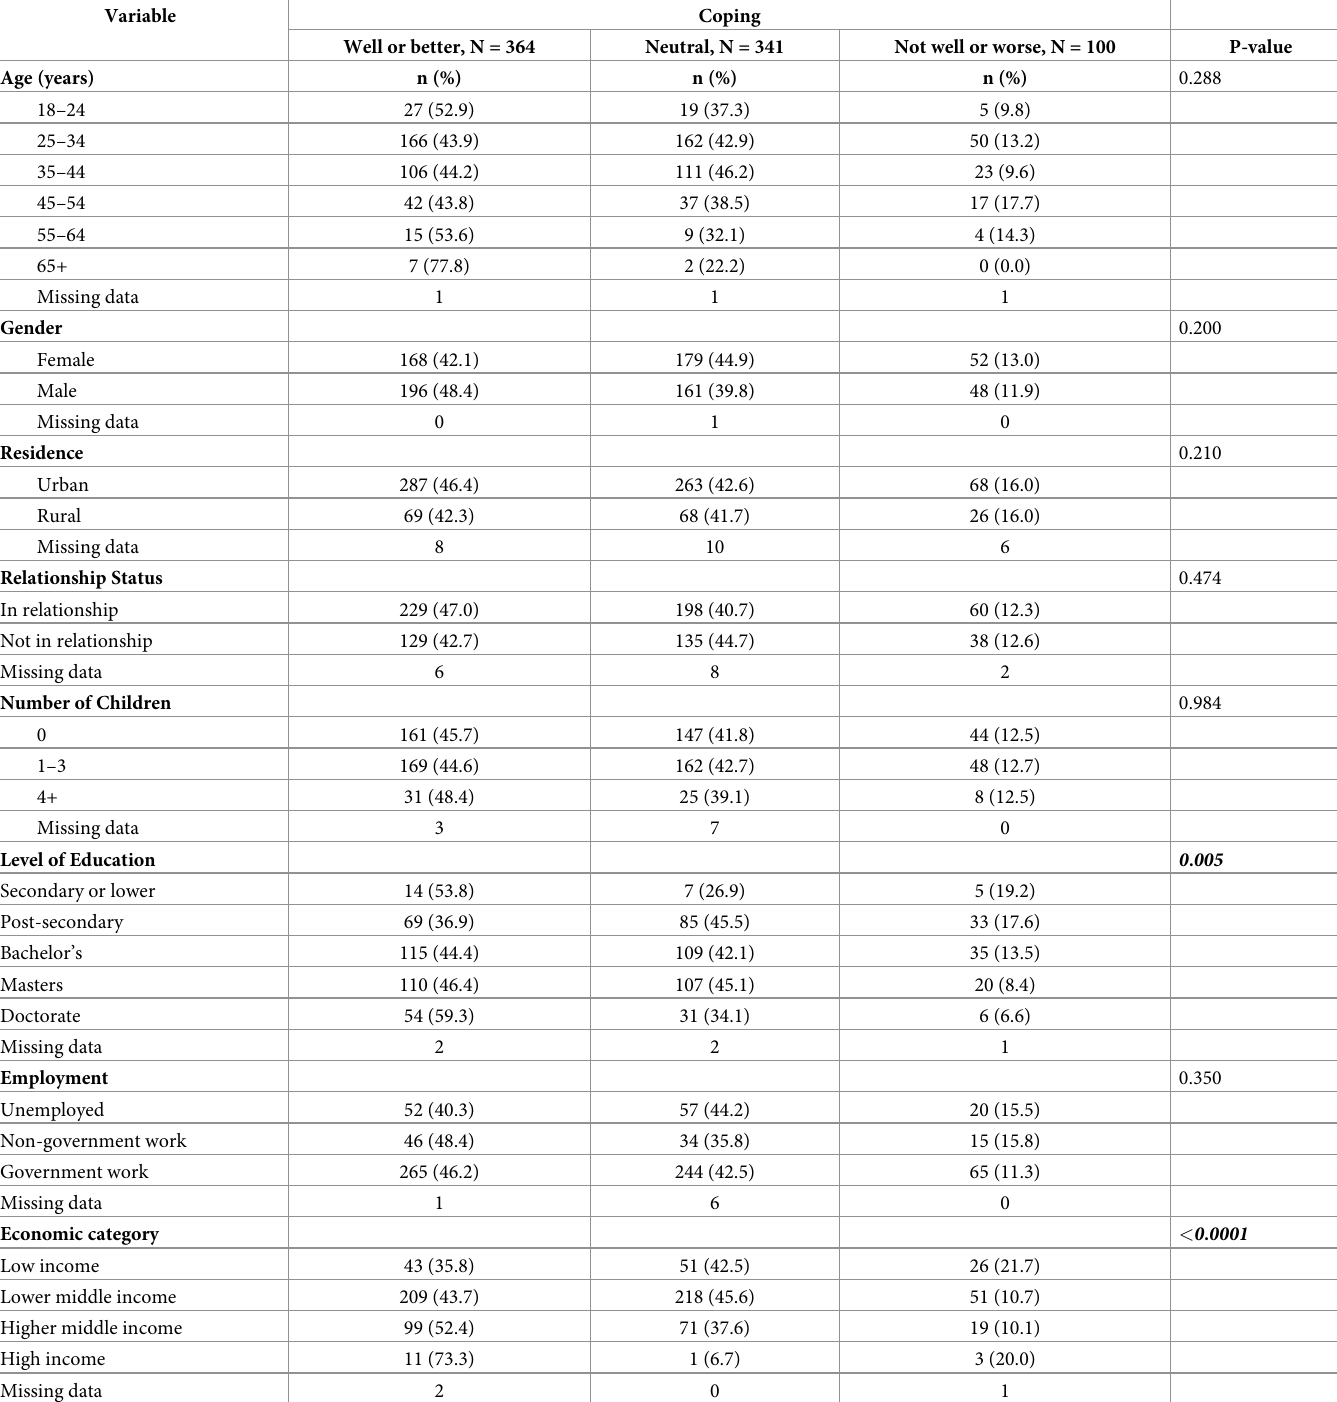
Table 4. Association between coping and demographic